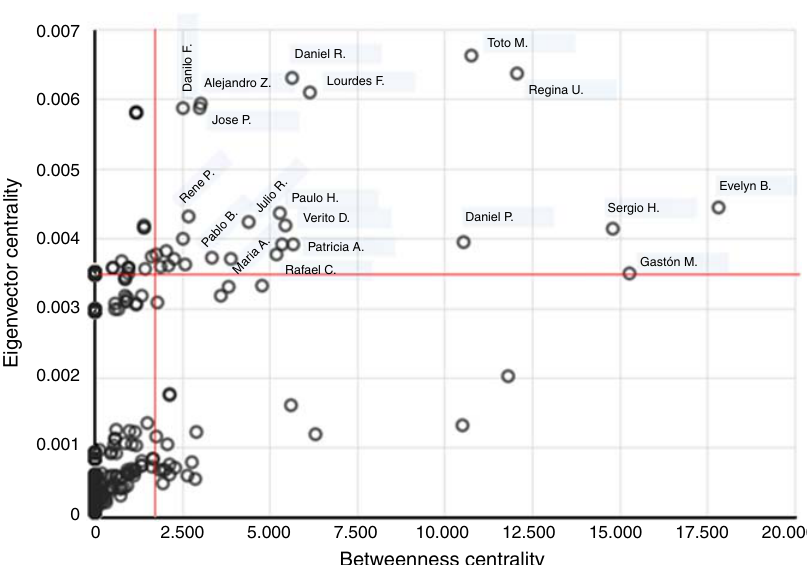
Figure 7. Scatter plot representing users of the official Buenos Aires marathon fan page on Facebook between August 31, 2015 and October 17, 2015 according to their betweenness centrality (X-axis) and eigenvector centrality